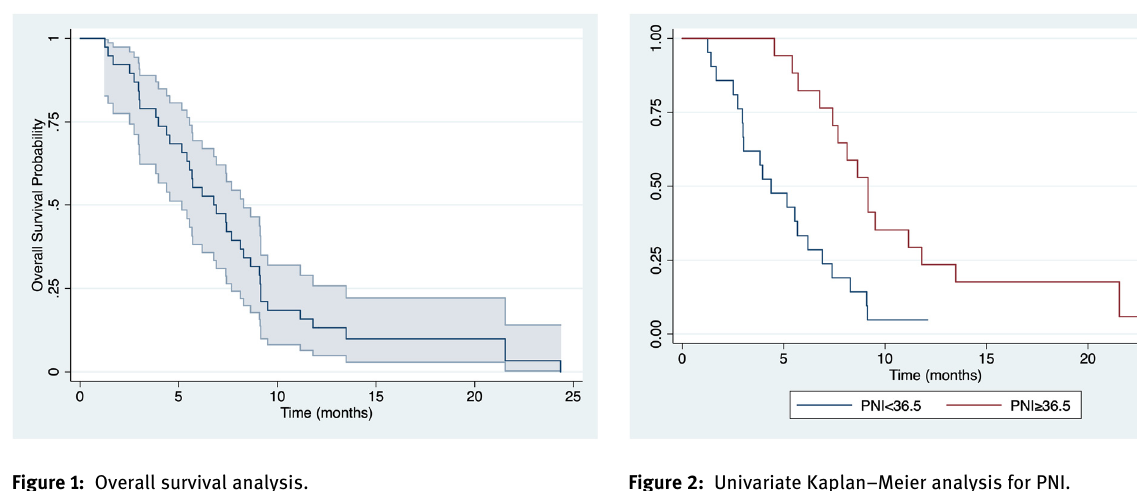
Figure 1: Overall survival analysis.